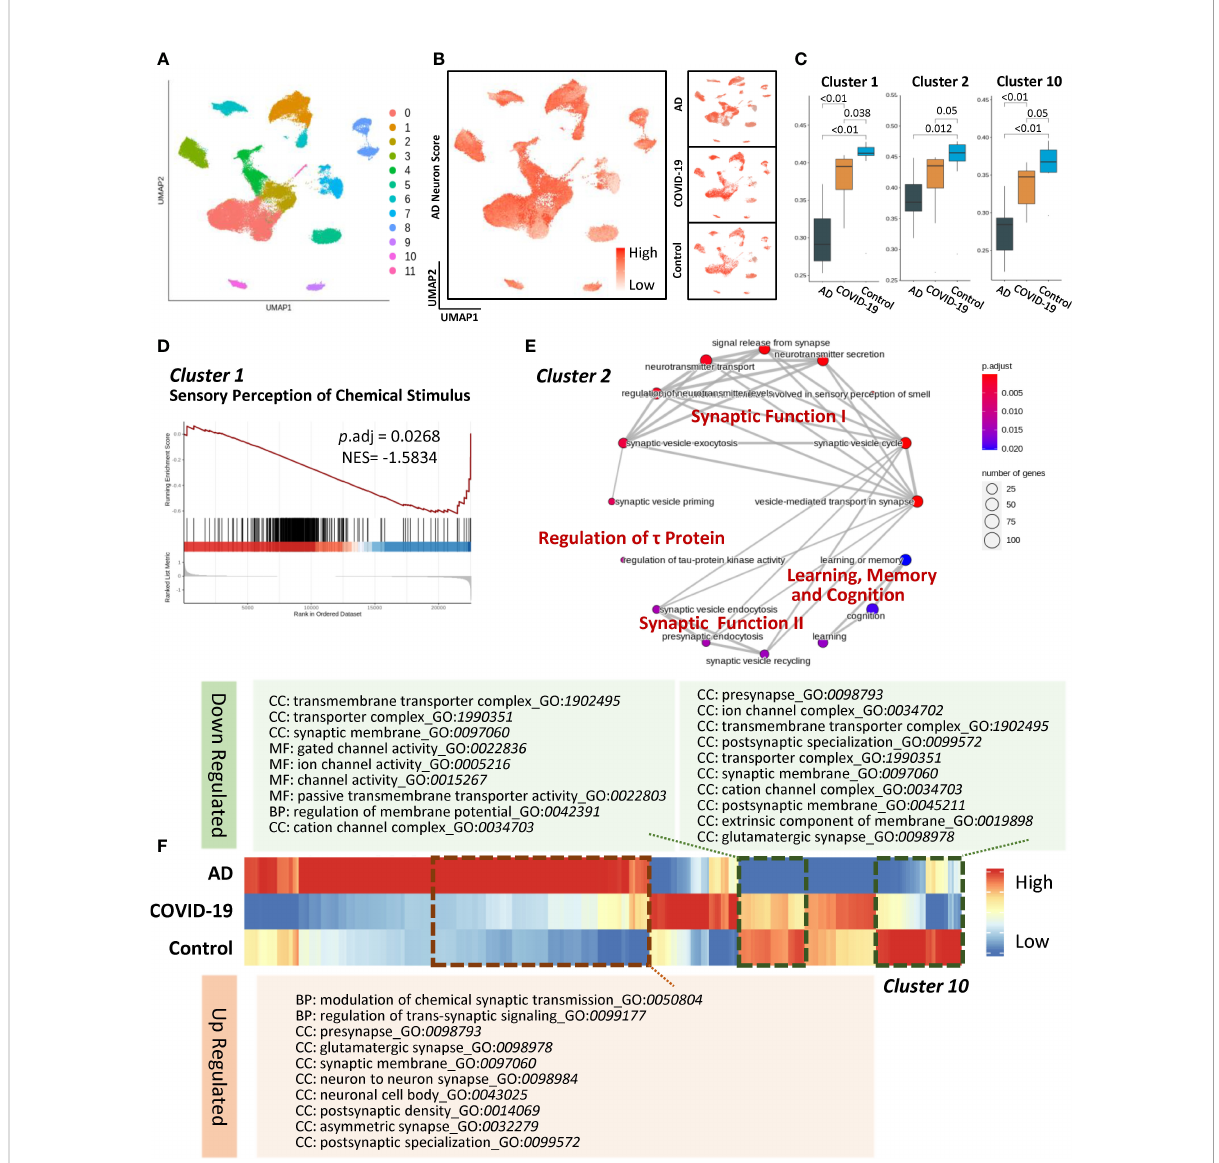
FIGURE 3 Characteristics of disease-associated excitatory neuron subpopulations. (A) UMAP embedding of all excitatory neurons coloured by cluster. (B) AD neuron score overlaid on UMAP showing the expression of AD-related gene sets of the cells. Right panels show the same value in each group. (C) Composition comparison for astrocyte cluster 1, cluster 2, and cluster 10 showing signi fi cant differences among groups. (D) GSEA result of cluster 1 showing downregulated sensory perception of chemical stimulus with adjusted P value less than 0.05. (E) Network of